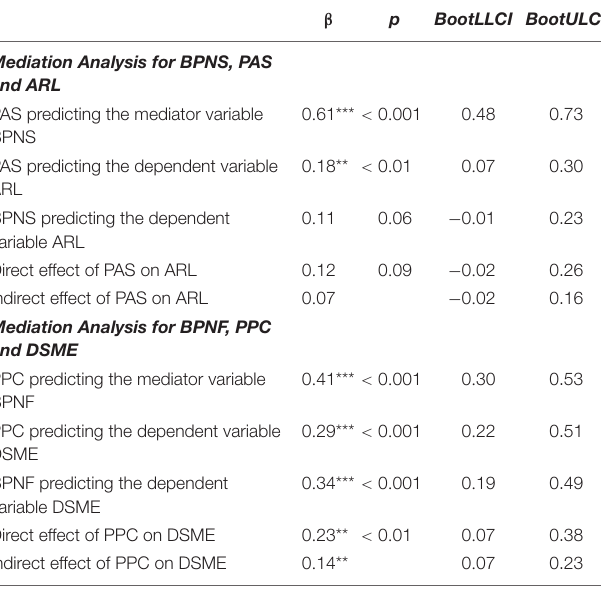
TABLE 3 | Summary of mediation analysis